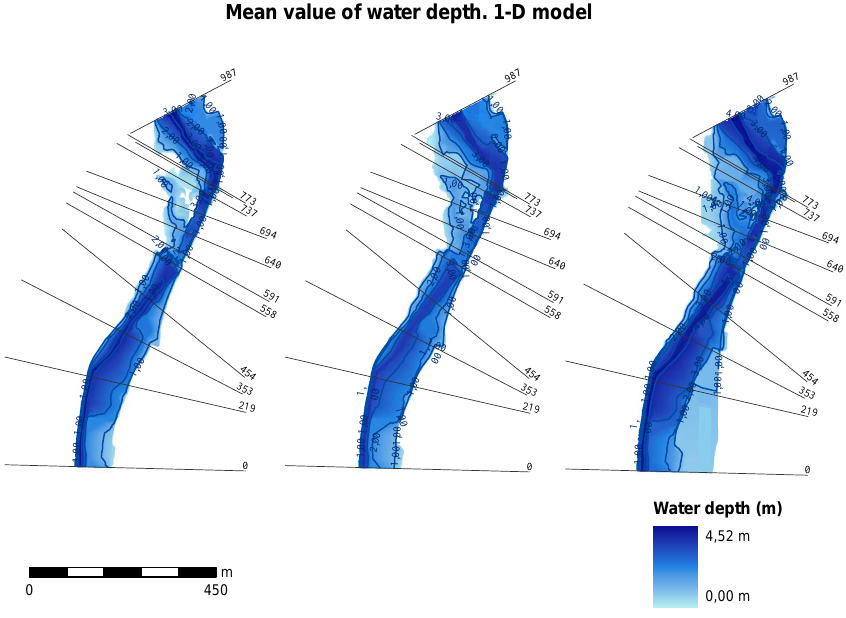
Fig. 12. 1-D HEC-RAS model. Flood maps with mean values of water depth predicted by point-estimate method for flow cases of 200m 3 s − 1 (left panel), 300m 3 s − 1 (middle panel) and 500m 3 s − 1 (right panel).